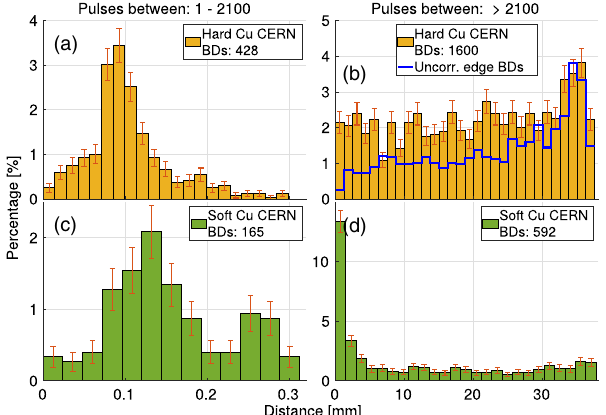
FIG. 9. Distributions of distances between ramping break- downs near the previous breakdown spot [same as Fig. 8(a)] and the radii of cathode breakdown craters compared, both from hard Cu